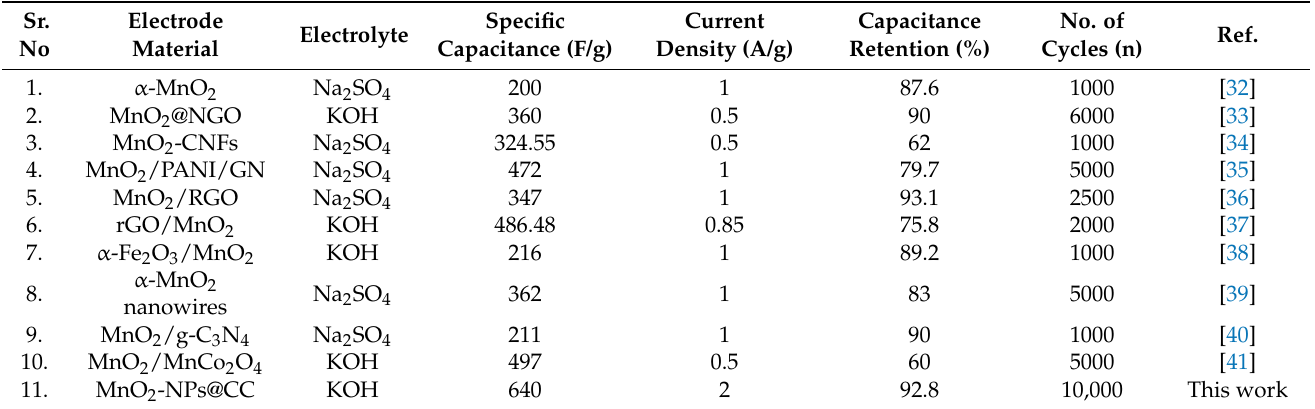
Table 1. A comparison of MnO 2 -based supercapacitor electrodes reported in previously published studies.